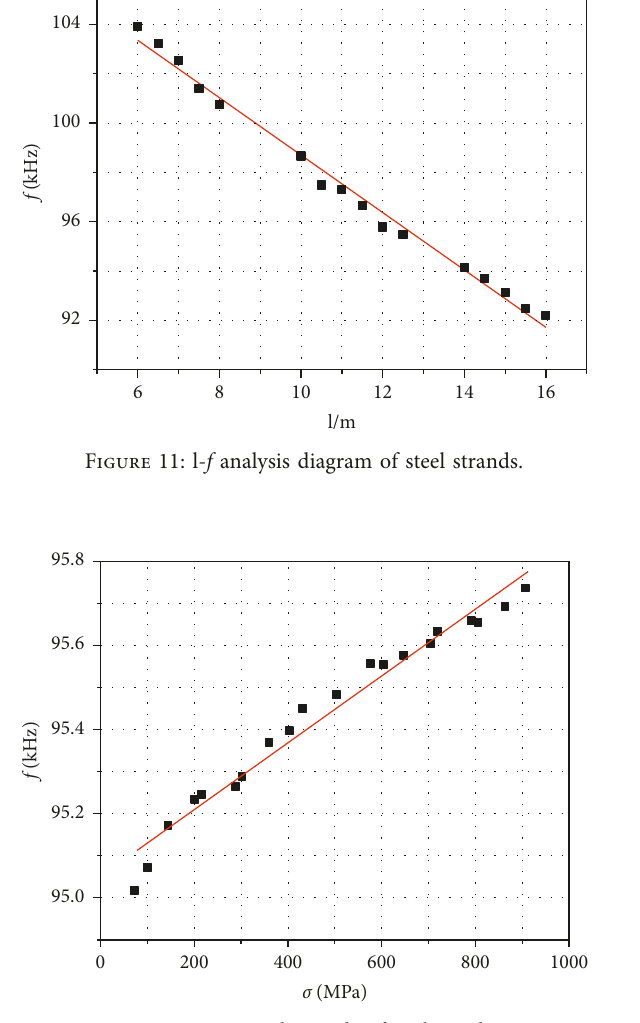
Figure 12: 14m steel strand σ - f analysis